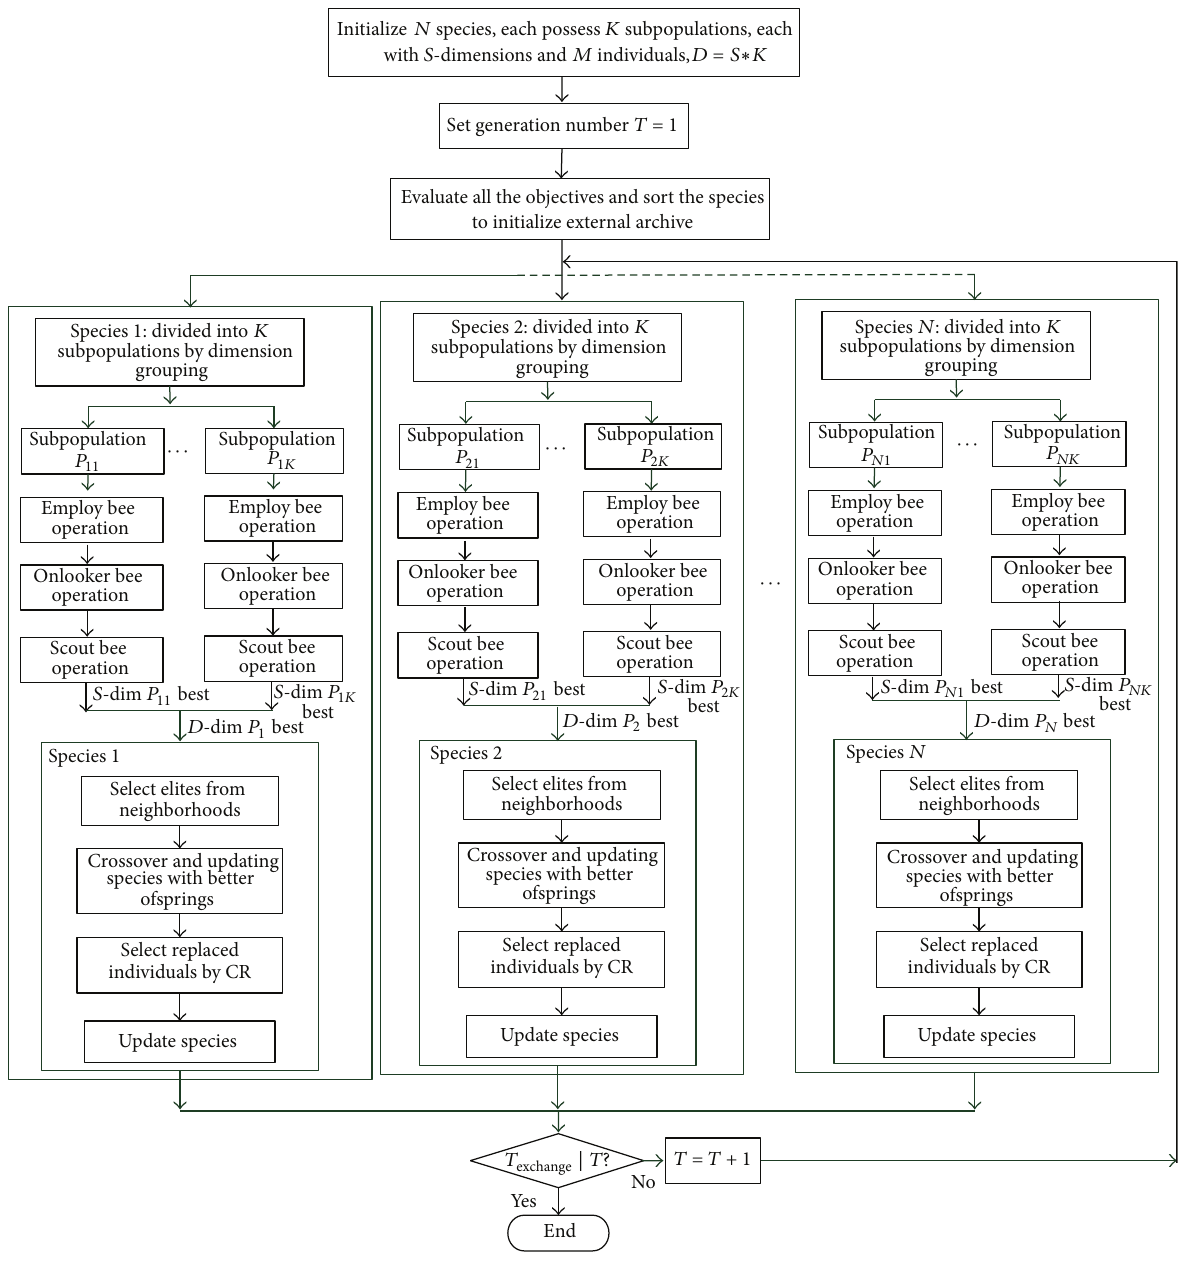
Figure 3: Flowchart of the HABC